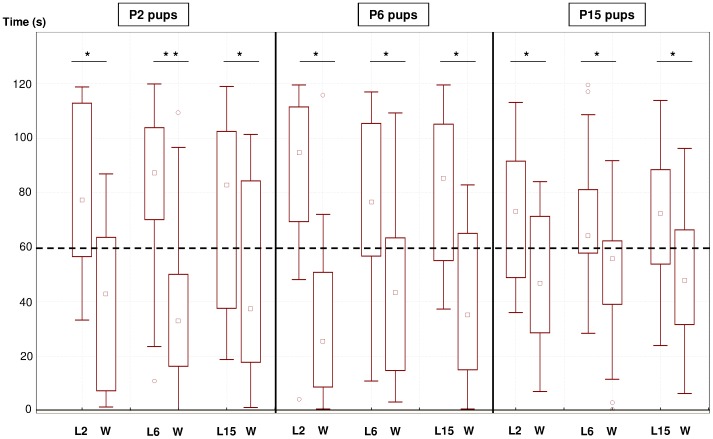
Relative attraction to the odors of milk samples from different lactational stages.Box plot of the duration 2, 6, and 15 day-old (P2, P6 and P15) mouse pups spent oriented to: 1) milk of lactation day 2 (L2) vs. milk of lactation day 6 (L6), 2) milk of lactation day 2 (L2) vs. milk of lactation day 15 (L15), and 3) milk of lactation day 6 (L6) vs. milk of lactation day 15 (L15). The dashed line indicates the theoretical level of random orientation. Wilcoxon's tests: ** p<0.01, * p<0.05. The central square within the box is the median; the box encloses the interquartile range; whiskers show 1.5 times the interquartile range, “o” indicate outliers.